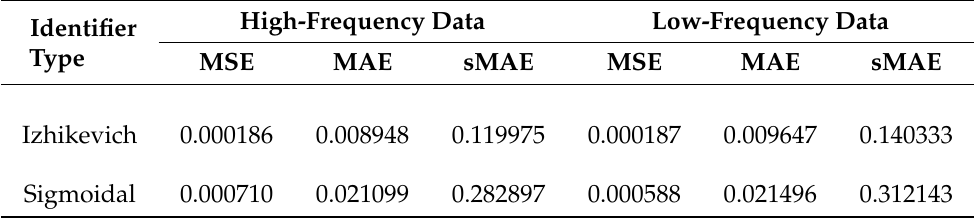
Table 2. Comparison of identification